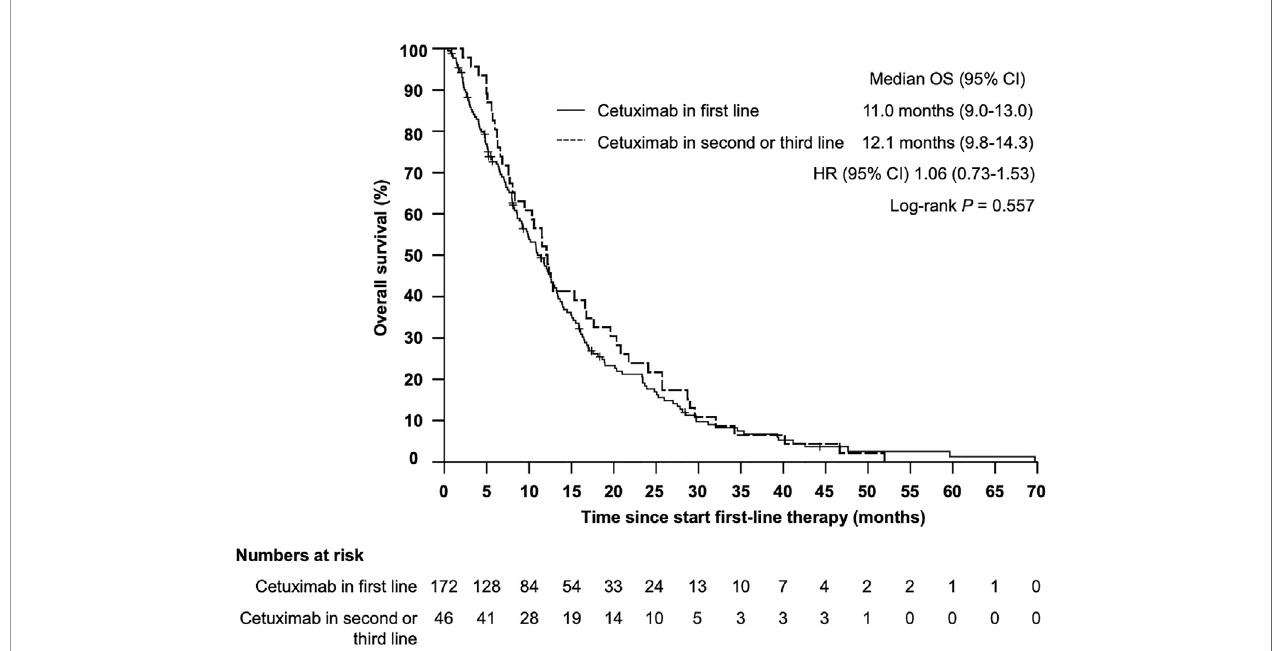
FIGURE 2 | Kaplan – Meier plot for overall survival (OS) from start of fi rst-line therapy for patients receiving cetuximab in fi rst vs cetuximab in second or third line. The median overall survival was 11.0 months (95% CI 9.0 – 13.0 months) vs 12.1 months (95% CI 9.8 – 14.3), P = 0.557.